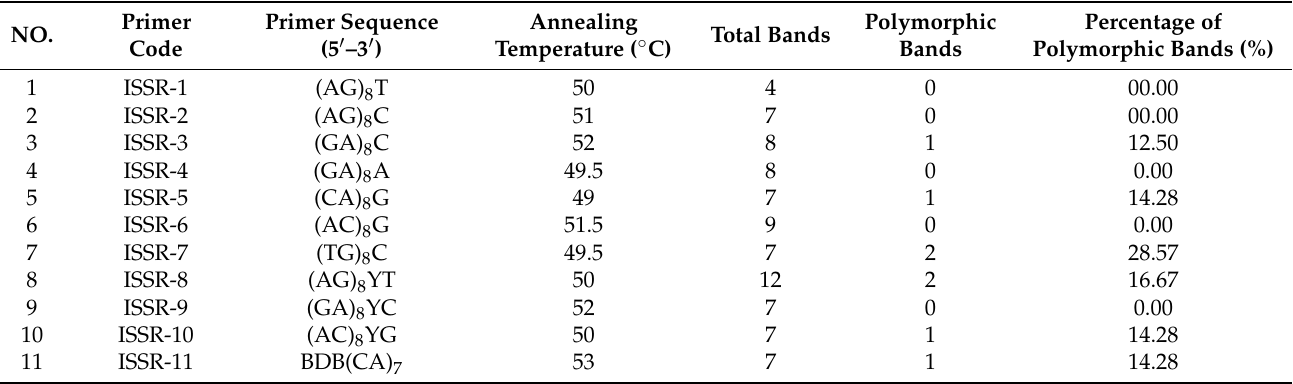
Table 1. Details of ISSR primers used in this